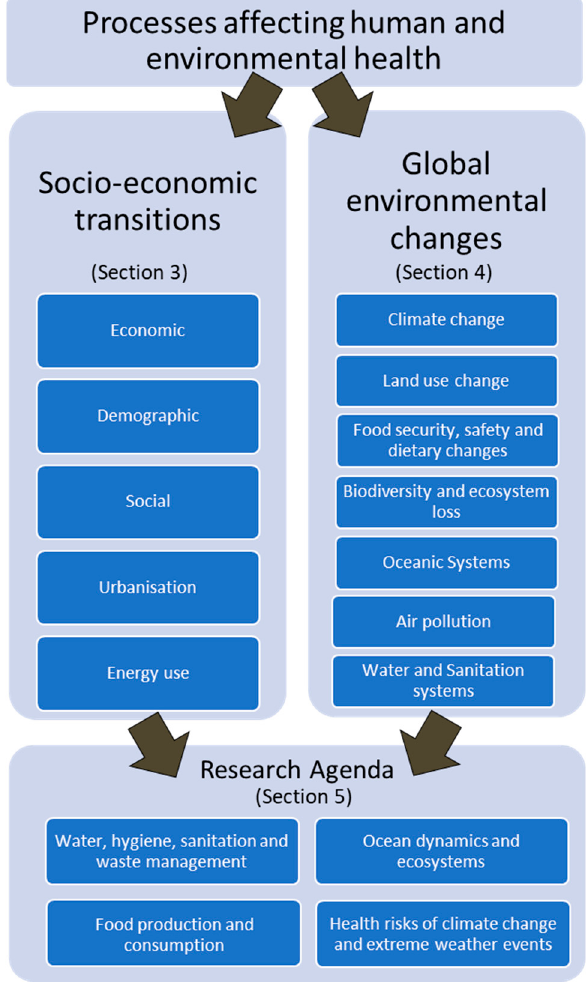
Figure 2. The Future Earth Health Knowledge Action Network (Health KAN) research agenda The Future Earth Health Knowledge Action Network (Health KAN) research categorization. agenda